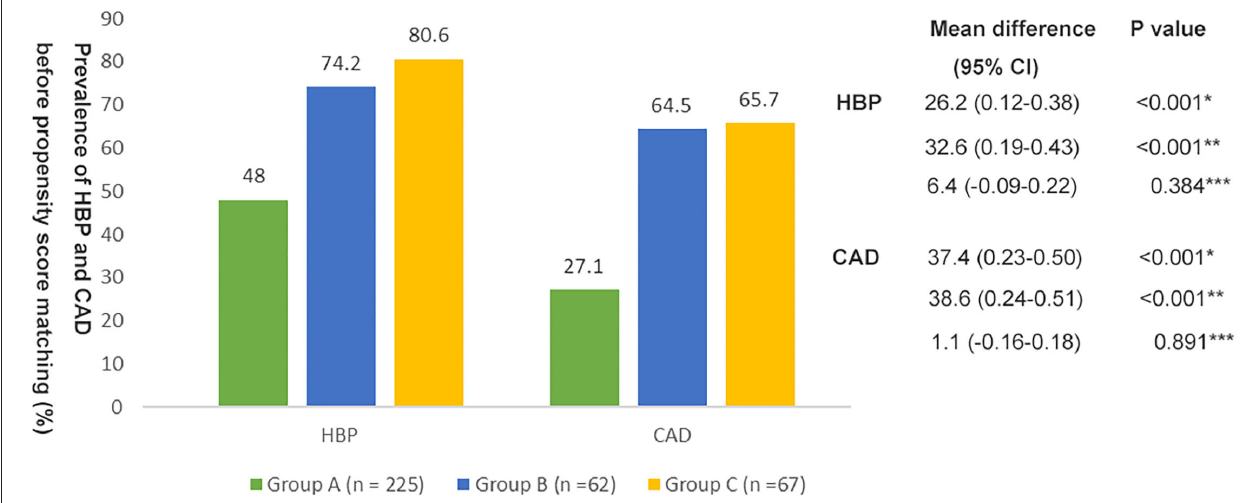
FIGURE 1 | Prevalence of hypertension (HBP) and coronary artery disease (CAD) in the three groups before propensity score matching. *Group A vs. Group B; **Group A vs. Group C; ***Group B vs. Group